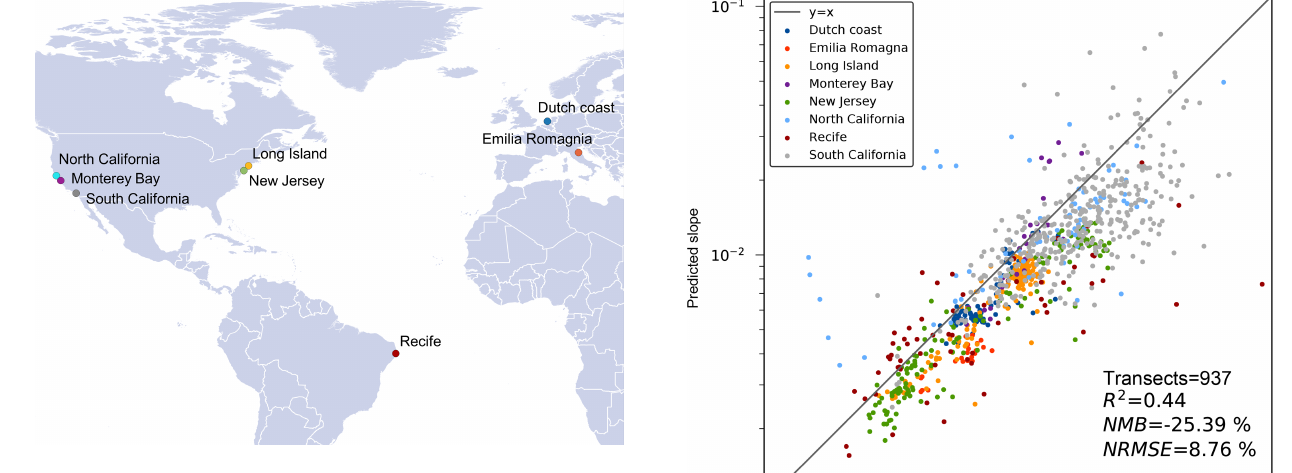
Figure 8. Field sites used for validation of the estimated global nearshore slopes.